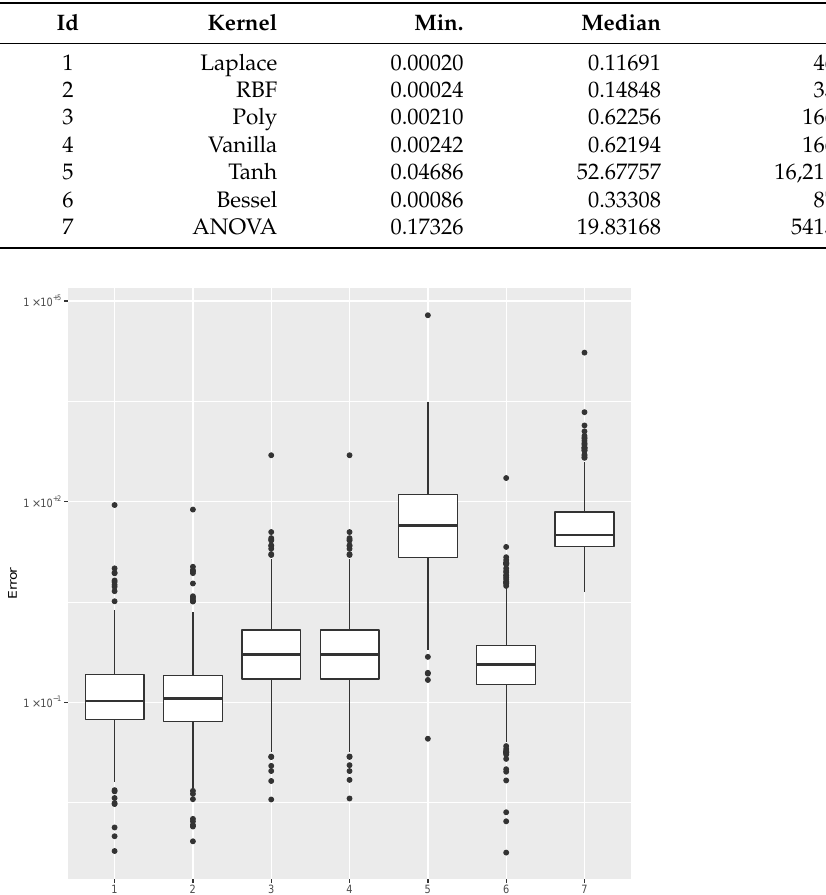
Table 3. Error statistics of the P critical estimate using distinct SVM kernel options.